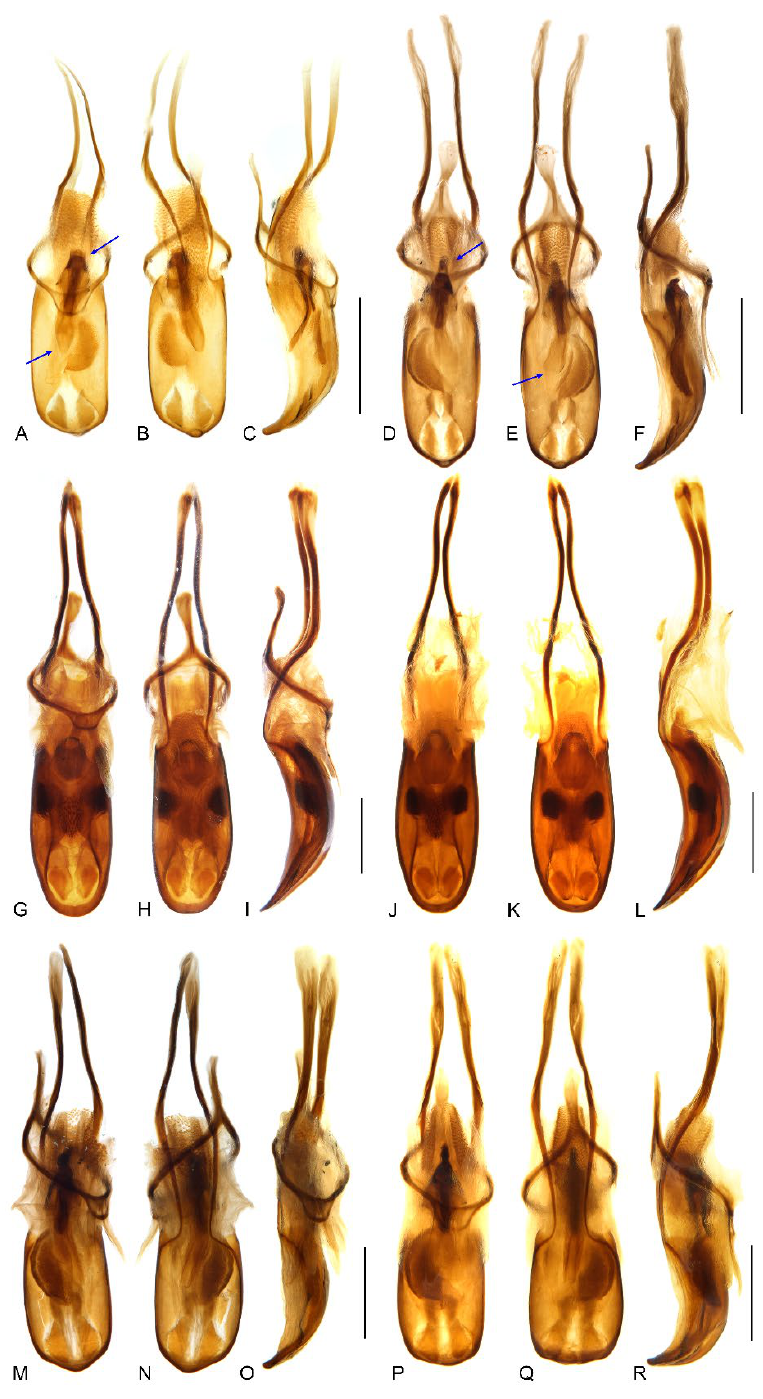
Figure 9. Male genitalia of Miltotranes : ( A ) M. prosternalis , north of Cairns (Cape Tribulation), dorsal view; ( B ) ditto, ventral view; ( C ) ditto, lateral view; ( D ) M. prosternalis , south of Cairns (Mission Beach), dorsal view; ( E ) ditto, ventral view; ( F ) ditto, lateral view; ( G ) M. subopacus , dorsal view; ( H ) ditto, ventral view; ( I ) ditto, lateral view; ( J ) ditto, with parameroid lobes removed, ventral view; ( K ) ditto, ventral view; ( L ) ditto, lateral view; ( M ) M. wilsoni sp. n., holotype, dorsal view; ( N ) ditto, ventral view; ( O ) ditto, lateral view; ( P ) ditto, paratype, dorsal view; ( Q ) ditto, ventral view; ( R ) ditto, lateral view. Fine differences in endophallus of M. prosternalis from north and south of Cairns indicated by blue arrows. Scale bars: 0.5 mm.